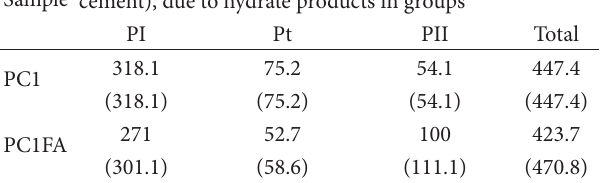
T 3: Weight loss during heating of the cement pastes PC1 and PC1FA on the 48th day of